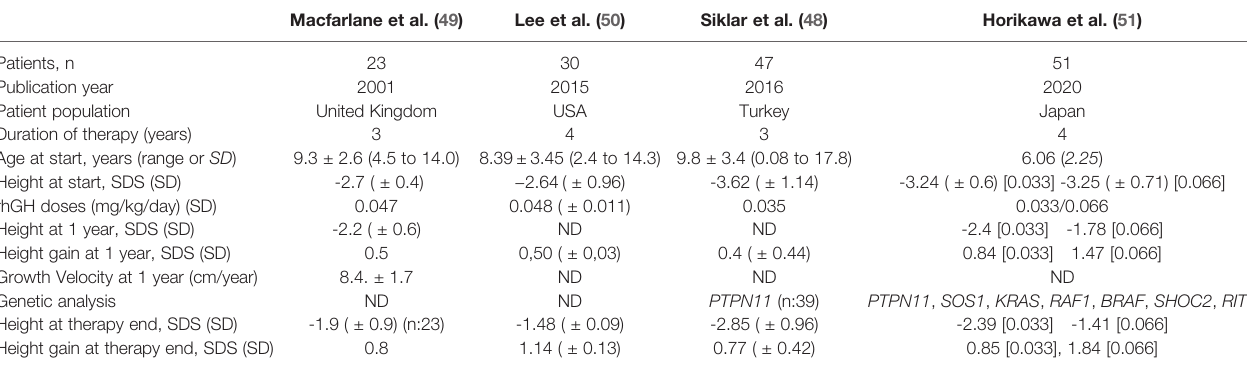
TABLE 1 | Published short-term studies in patients with Noonan syndrome treated with